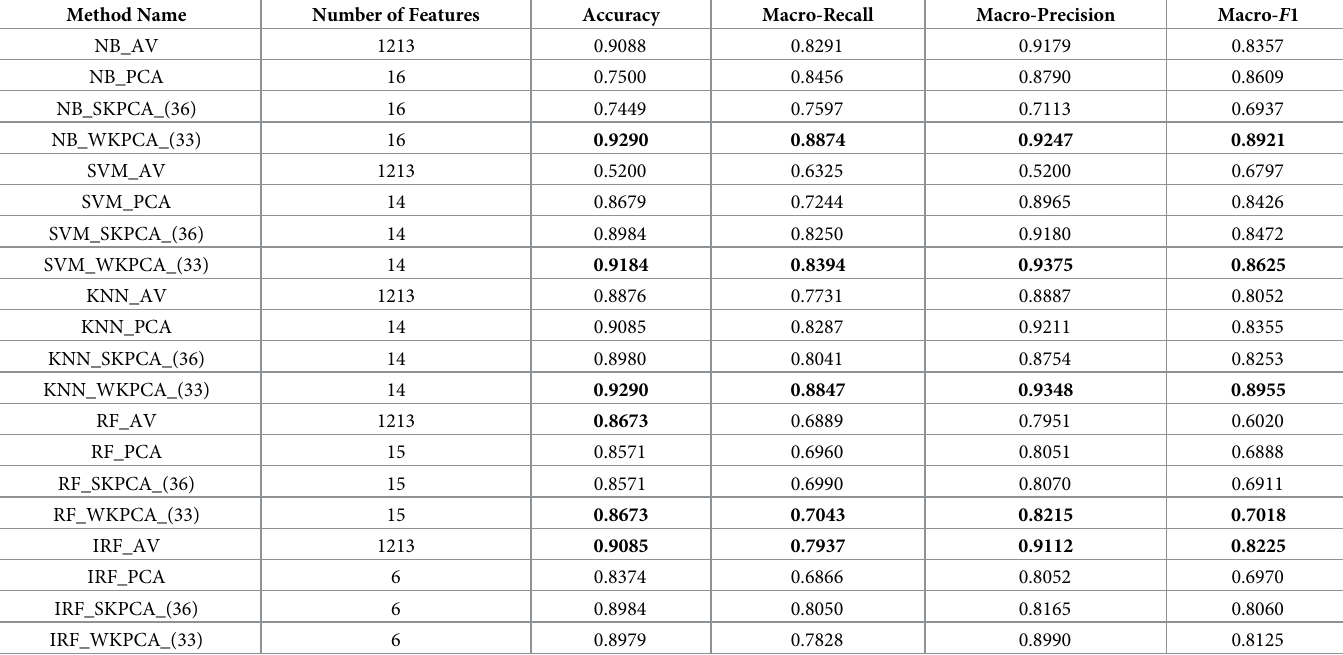
Table 3. Performance measurement comparisons of machine learning methods based on the Breast data set after WKPCA dimension reduction.